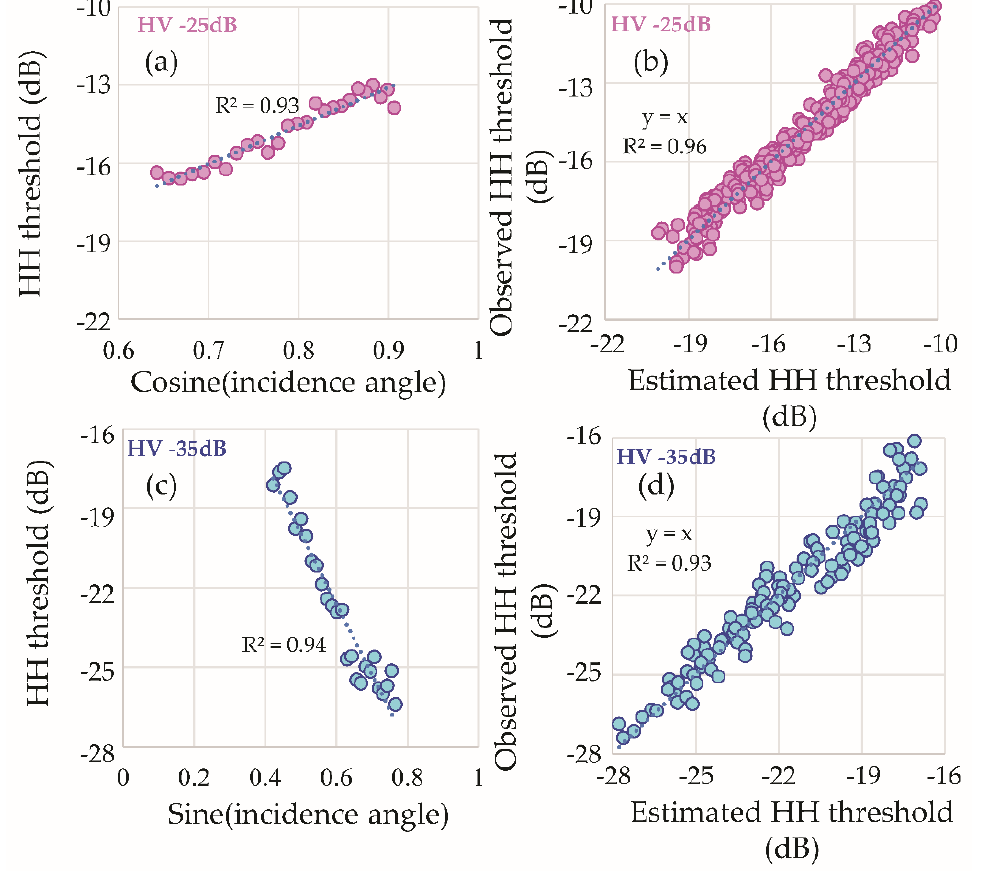
Figure 4. A sample of scatter plots of the threshold B values from ALOS-2/PALSAR-2-ScanSAR data (backscattering coefficients of HH microwave on a dB basis) obtained from every local incidence angle from 25 to 50 degrees (n = 26) whose pixel values of the HV microwave backscattering coefficient (hereafter HV σ 0 ) range from − 24.5 to − 25.4 ( a ). The relationship between the threshold B estimated by the hierarchical Bayesian model and the observed threshold B collected at every incidence angle from 25 to 50 degrees and every HV σ 0 value from − 31 to − 19 dB (n = 338 (26 × 13)) ( b ). A sample of scatter plots of threshold C obtained from every local incidence angle from 25 to 50 degrees (n = 26) whose pixel values of HV σ 0 range from − 34.5 to − 35.4 ( c ). The relationship between the threshold C estimated by the hierarchical Bayesian model and the observed threshold C collected at every incidence angle from 25 to 50 degrees and every HV σ 0 value from − 36 to − 32 dB (n = 130 (26 × 5)) ( d ). The horizontal axis of the histogram of subfigures ( a , c ) indicates cosine/sine values of every local incidence angle.